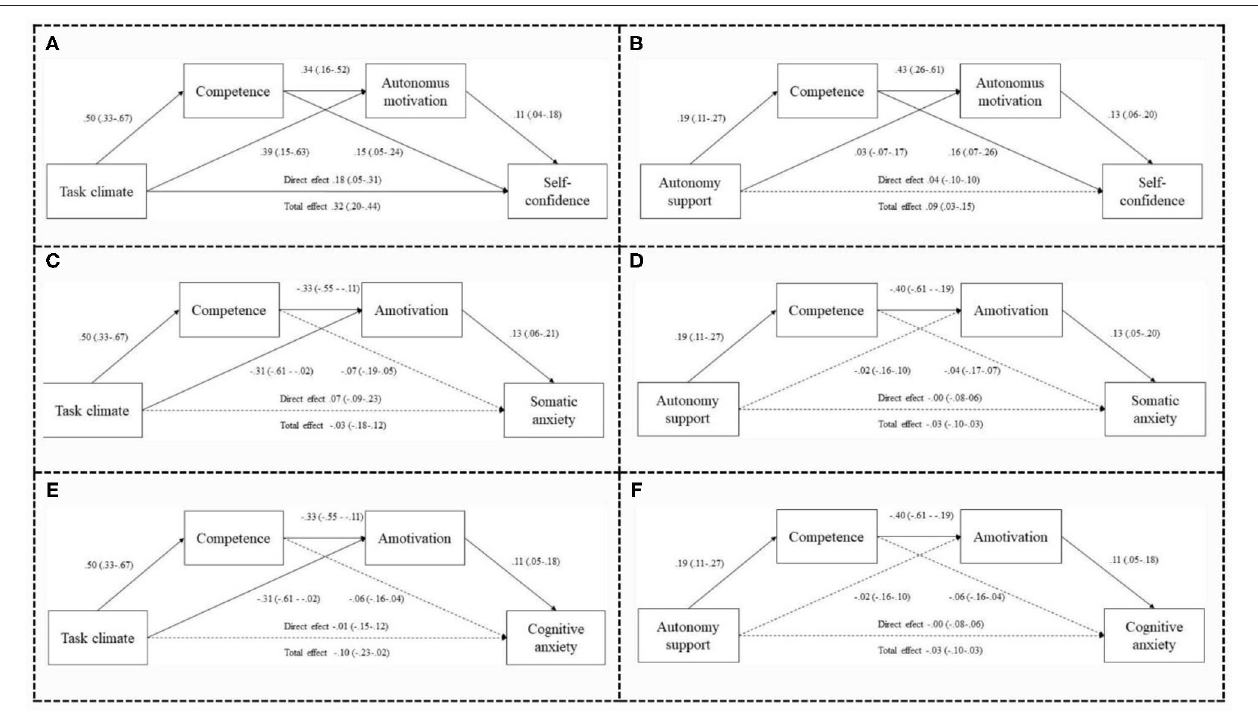
FIGURE 3 | Serial mediation models. 95% CI estimate indicates a significant indirect effect. Significant effect—continuous lines; non-significant effect—dashed lines. (A–F) Refers to each of the serial mediation models tested.